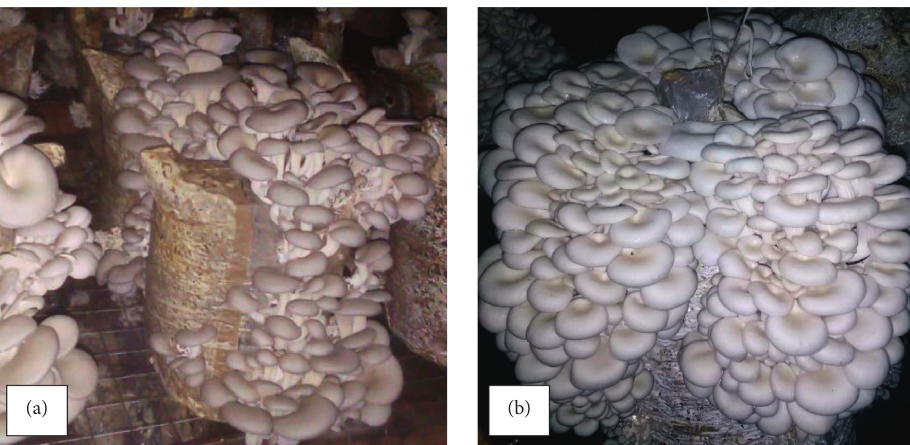
Figure 2: Pictures showing mushroom sprouting out of baobab fruit shells